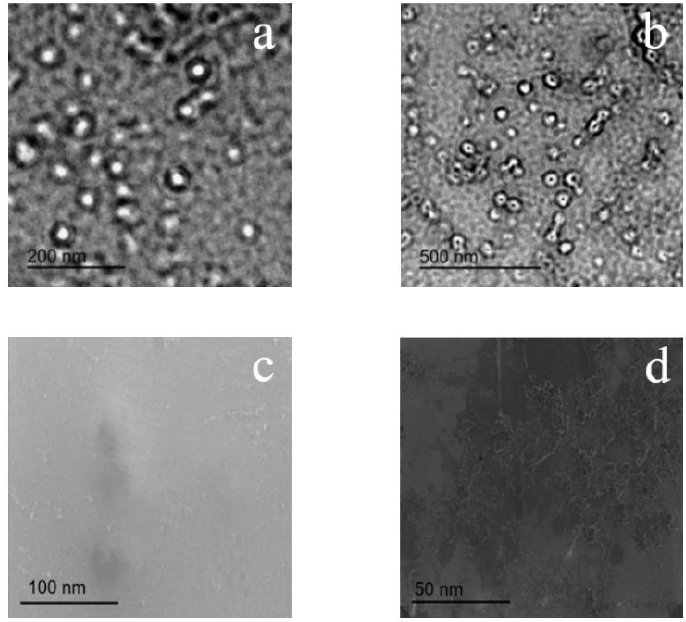
Fig. 3. TEM images of (a) WPUA and (b) SiO 2 -NH 2 -GO/WPUA 0.75%; SEM images (c) SiO 2 -NH 2 -GO/WPUA 0.75% and (d) SiO 2 -NH 2 -GO/WPUA 1.0% soft segment at about 350°C [26].